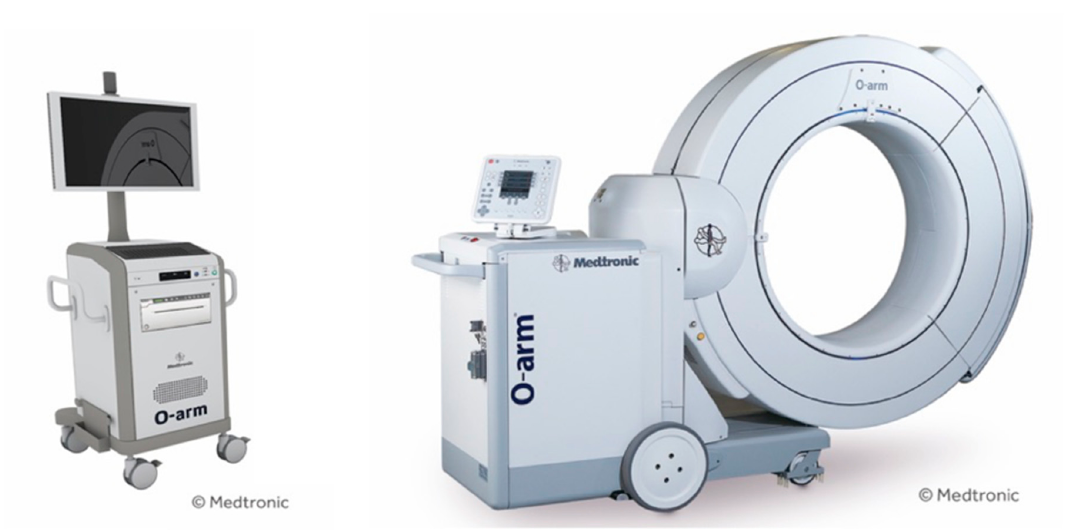
Figure 1. O-arm ® and navigation device. The X-ray tube and flat-panel detector (FPD) rotate 360 ◦ inside the gantry, and three-dimensional (3D) scanning can be performed in approximately 13 s. High-precision 3D reconstruction is possible in a short amount of